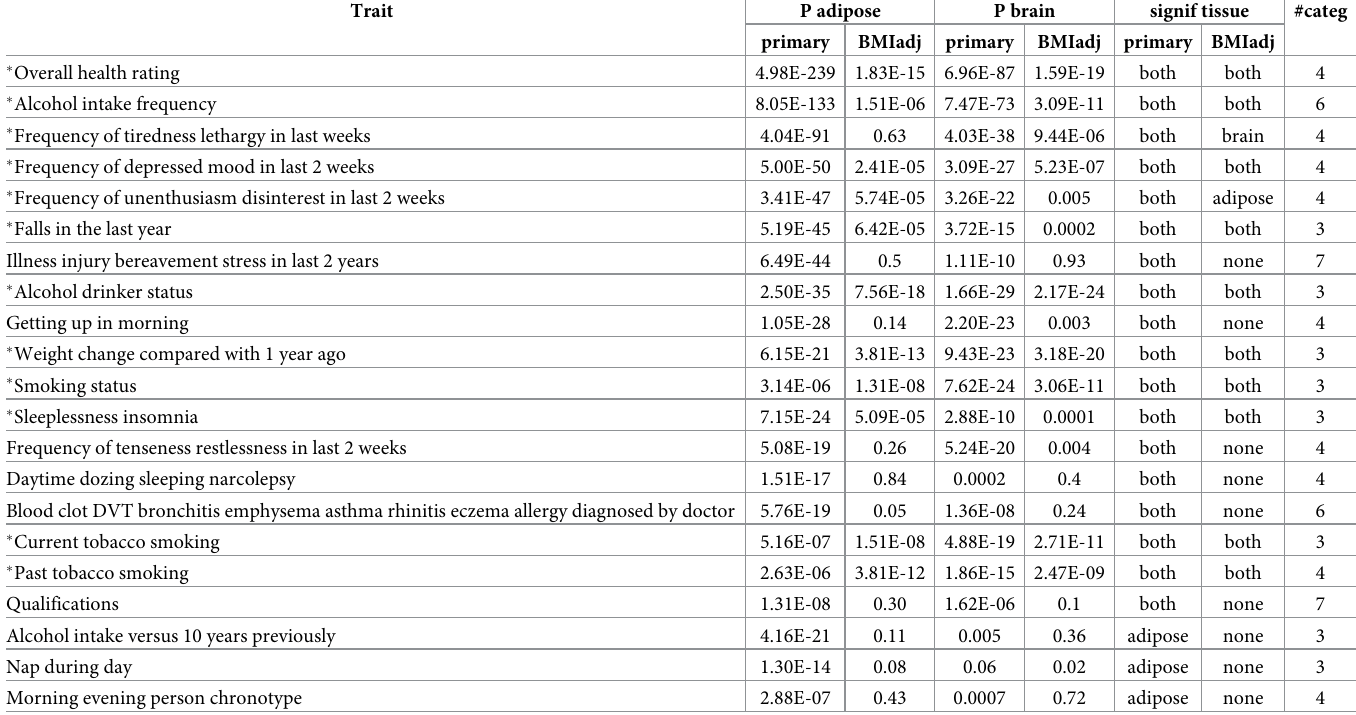
Table 2. Qualitative/Categorical traits with three or more categories that are differentially distributed between at least one of the adipose and brain-specific subtype groups of individuals for BMI and the remaining population. For each trait, we provide the p-values of testing heterogeneity between each tissue-specific subtype group of individuals and the remaining population before (primary) and after BMI adjustment (BMIadj). For each trait, tissue-specific groups which appear to be significantly heterogeneous (signif tissue) before (primary) and after BMI adjustment (BMIadj) are also provided. The asterisk mark attached to the traits indicate which trait remains differentially distributed between at least one of the tissue-specific groups and the remaining population after BMI adjustment. The number of categories for each trait (#categ) are also